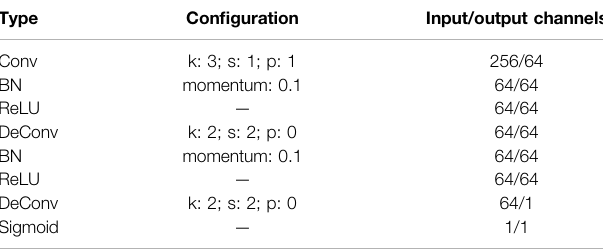
TABLE 1 | SPN segmentation prediction module details. “ Conv ” : convolution operator; “ BN ” : batch normalization; “ DeConv ” : de-convolution operator; “ k ”